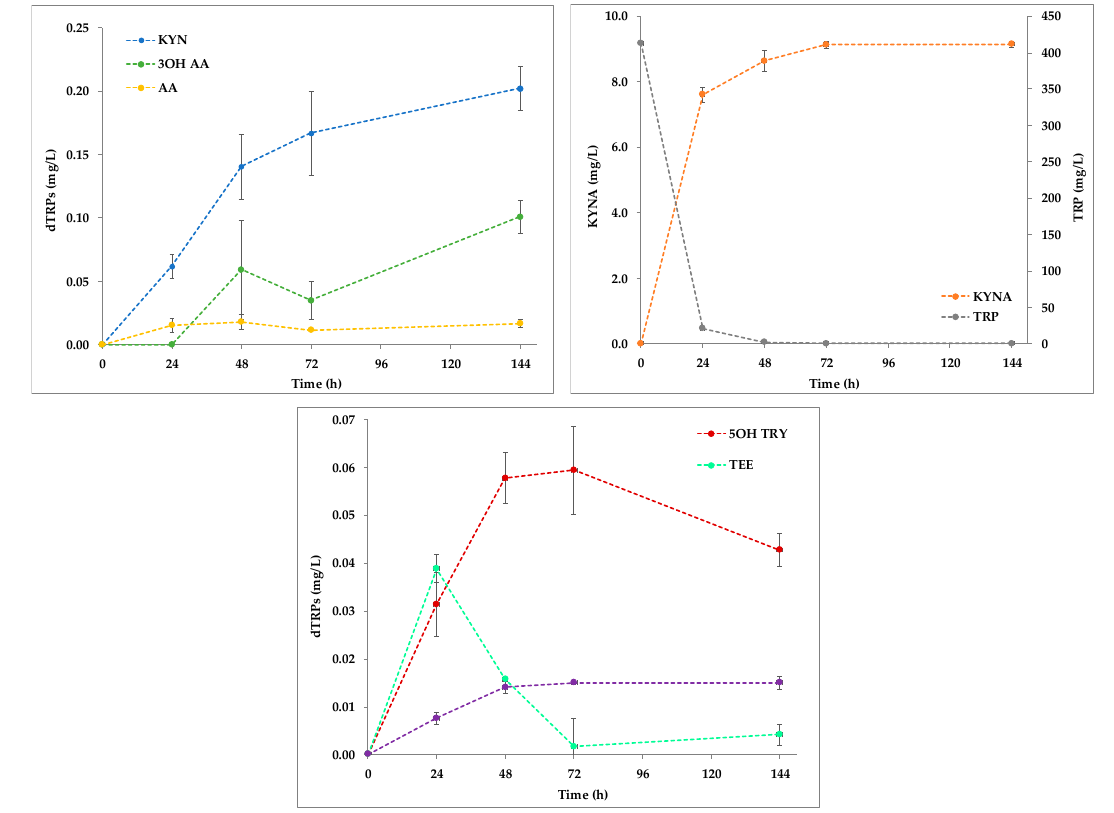
Figure 5. TRP derivatives produced by S. cerevisiae EC1118 in YNBT400 medium. Error bars indicate the standard deviation.